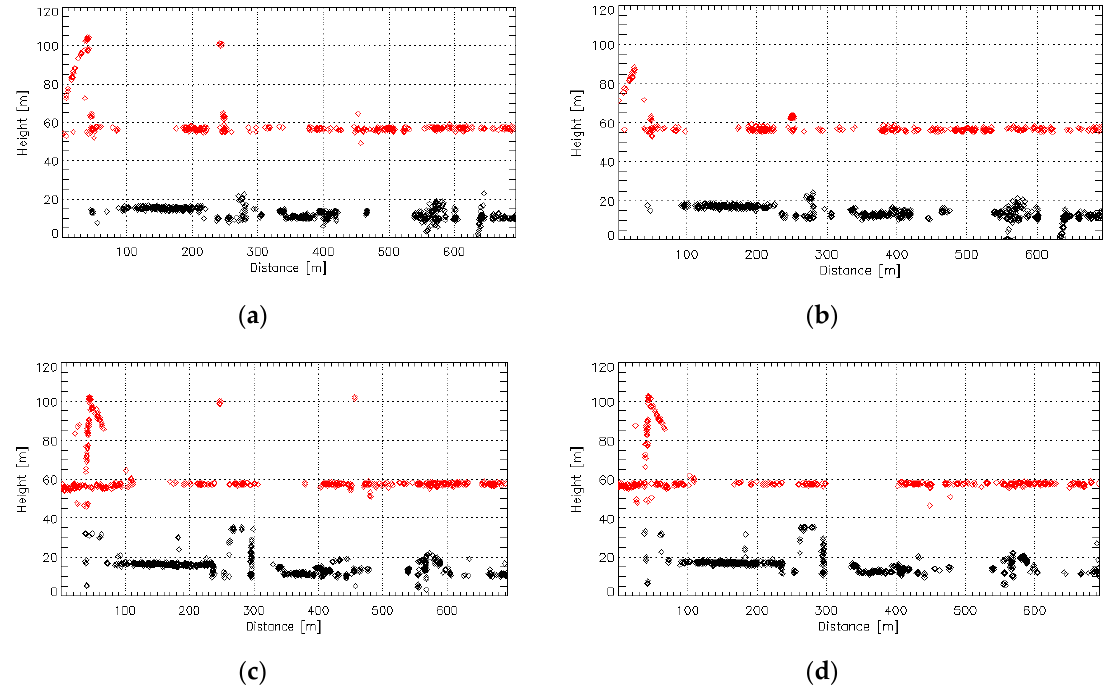
Figure 5. Plots of the estimated height of the coherent pixels located within the yellow rectangle in Figure 4 for ( a ) SBAS and ( b ) TomoSAR results achieved for the ascending dataset, and ( c ) SBAS and ( d ) TomoSAR results relevant to the descending dataset. Red and black diamonds correspond to measurement points located on the roadway, pillars and cables and at the ground level, respectively. Horizontal axis corresponds to the longitudinal distance from the origin of the yellow rectangle located at its southern/eastern end, as reported by the white graduated scale in Figure 4.